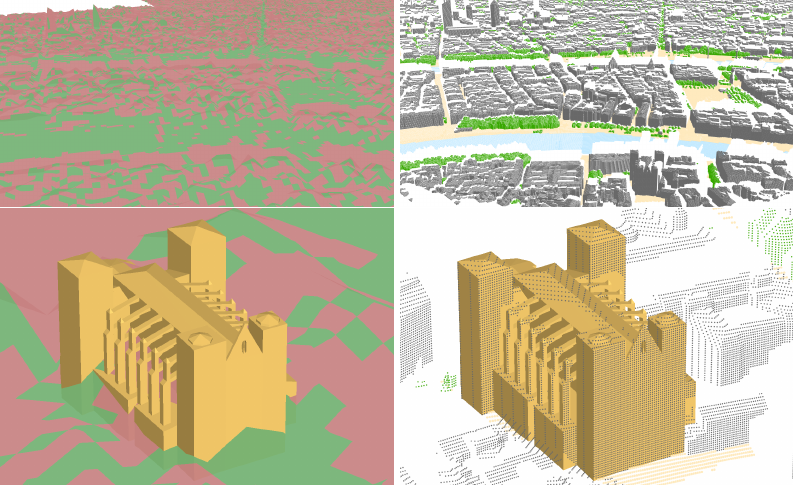
Figure 14. Three-dimensional visualizations to compare the results of 2.5D raster ( left ) and 3D vector ( right ) visibility analyses from the vantage point of the Fourvière Basilica. On the raster analysis, the visible areas are in green, while on the vector one, we only see the visible 3D points colored according to their type. The 3D model of Saint Jean’s Cathedral has been added to the bottom visualizations, which zoom in on the panoramic view of the top images.